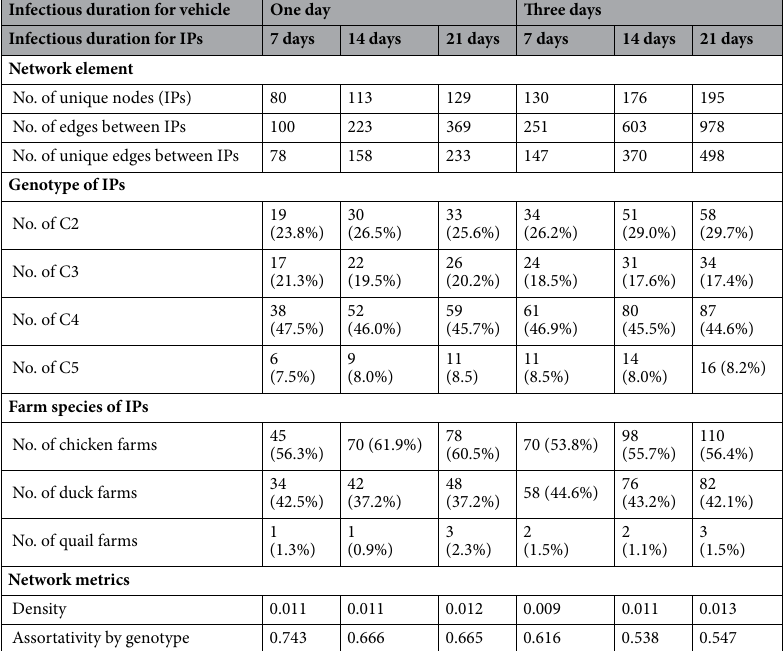
the same, the estimated probability of a tie formation between HPAI H5N6 virus-infected premises for a 1 km increase in geographical distance between two farms reduced. LQ-QAP analysis showed the lowest Bayesian information criterion (BIC) value for seven-day infectious periods for IPs and one-day periods for PPHaVs. Bayesian inference. To estimate the contribution of vehicle movements originating from 259 HPAI H5N6 virus IPs of 343 IPs to spreading HPAI H5N6 virus, we conducted Bayesian inference to estimate the parameters associated with the force of infection of vehicle movements and other factors. Table 3 summarizes the estimated contribution rate of introducing a specific genetic type of HPAIV H5N6 to an individual farm via PPHaV move- ments originating from another IP or other sources of infections through the simulation using the force of infec- tion parameters previously estimated by Bayesian inference. The posterior parameters for force of HPAI H5N6 infection due to one contaminating PPHaV entry coming from IPs was estimated to differ with the infectious periods of the genotype of IPs and vehicle movement (see Supplementary Table S3 and Fig S2–S3 online). The deviance information criterion (DIC) was decreased in the model employing a three-day infectious duration for vehicle movements except in the case of C3-genotype HPAIV H5N6 infection, where the one-day infectious duration model was preferred (see Supplementary Table S3 online). Overall, 259 IPs (75.5% of all IPs) with both a visit log for GPS-equipped vehicles and phylogenetic clas- sification information and 6,280 non-IPs were used to estimate the contribution of potentially contaminating movements to HPAI H5N6 transmission between poultry premises. Apparently, 38.7% of IPs that had visiting records from registered vehicles were directly interlinked with other IPs. The proportion of HPAI H5N6 spread via potentially contaminating vehicle movement differed with the genotype of IPs related to potentially contami- nated vehicle movement in preferred models. On average, 28.3% of 259 IPs were transmitted HPAIV H5N6 via PPHaV movement in which 13.7% of interconnection occurred between IPs and 86.3% of links occurred between IPs and non-IPs, whereas 71.7% of 259 IPs were given HPAIV H5N6 by other sources. When C4-genotype IPs were associated with potentially contaminated vehicle movement, 46.0% of IPs had an infection with three-day infectious PPHaV entries; in contrast, 31.7% of poultry holdings had an infection via C3-genotype IPs associated with potentially contaminated vehicle movement that were presumed to transfer virus for one days. Moreover, the IPs origin vehicle movement that stayed infectious for three days were attributed to HPAI H5N6 infection for 23.5% of C2-genotype of IPs and 11.8% of C5-genotype of IPs. In addition, the interval between infection and reporting or sampling was estimated to be 5.91 days (5.89 days in the C2 IPs, 5.98 days in the C3 IPs, and 5.87 days in the C4 IPs). Furthermore, as shown in Fig. 2, there were spatially heterogeneous contact patterns between the same genotype of IPs via vehicle movements. A majority of contacts were established in the central part of the coun- try via PPHaV movements between infected poultry holdings at a close distance. The long-range contacts were